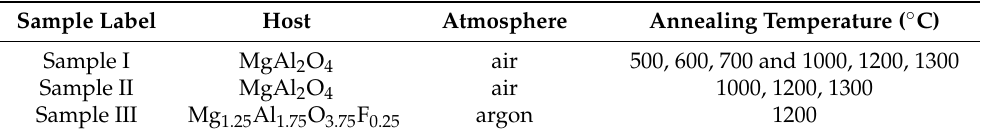
Table 1. Experimental conditions applied for the synthesis of ceramic spinels containing man- ganese